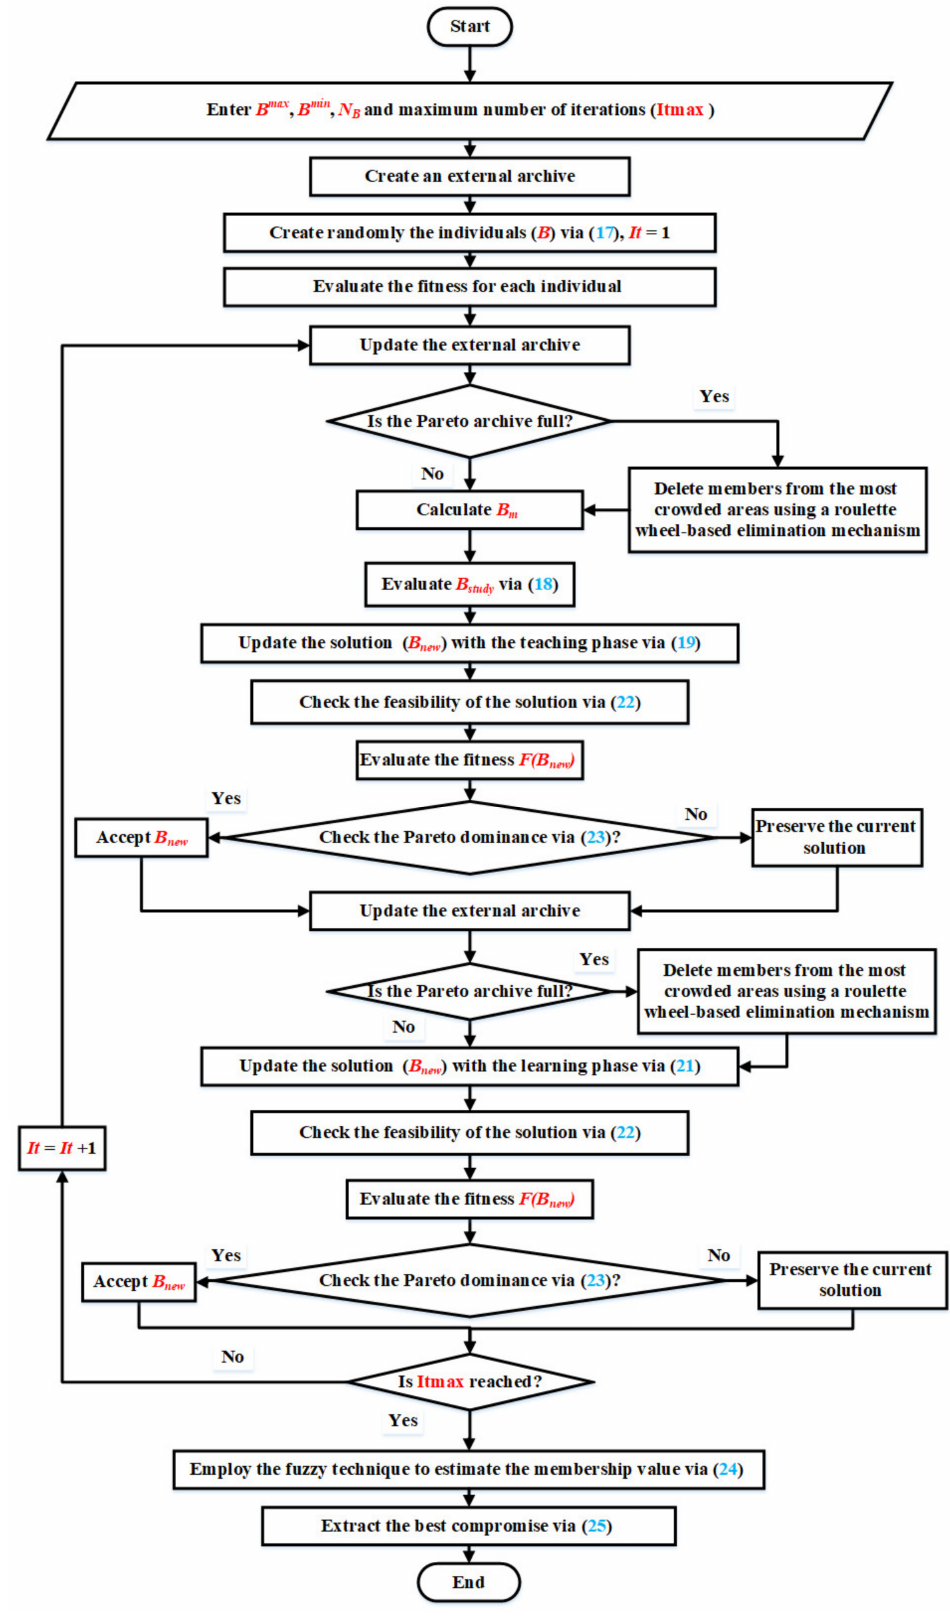
Figure 2. Proposed MTLSBA to solve the CHPEED